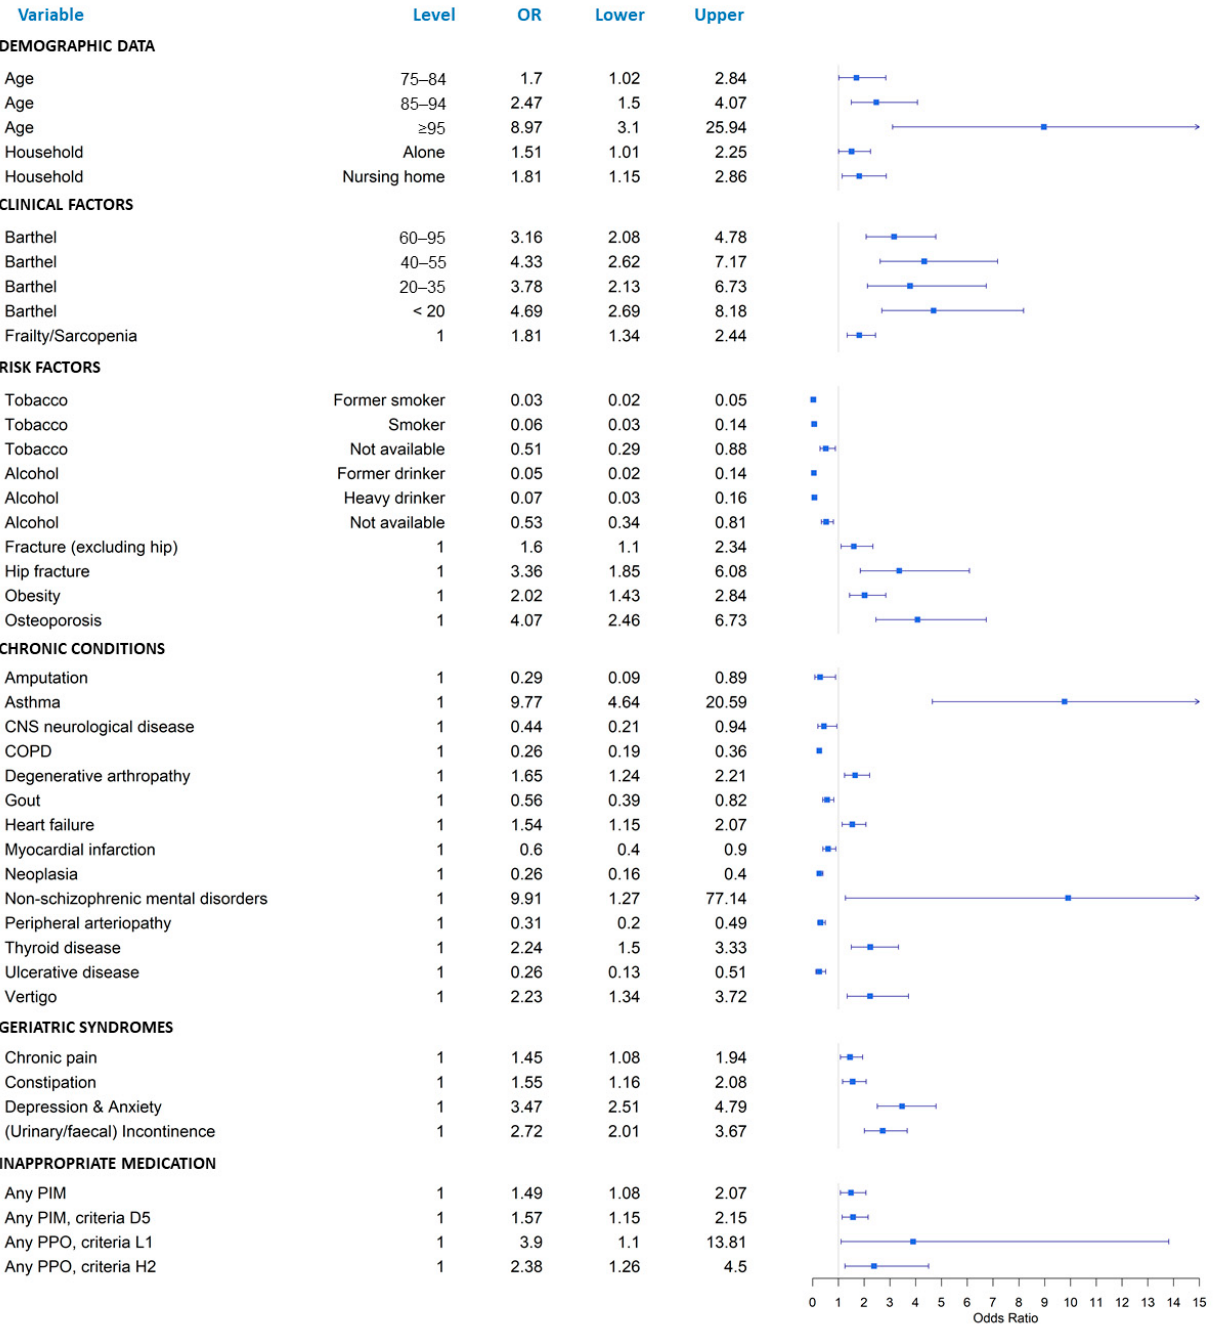
Figure 1. Forest plot of significant clinical and sociodemographic variables. Odds ratios and their upper and lower 95% confidence intervals are shown. Reference category: men. CNS: central nervous system. COPD: chronic obstructive pulmonary disease. PIM: potentially inappropriate medication. PPO: potential prescribing omission.